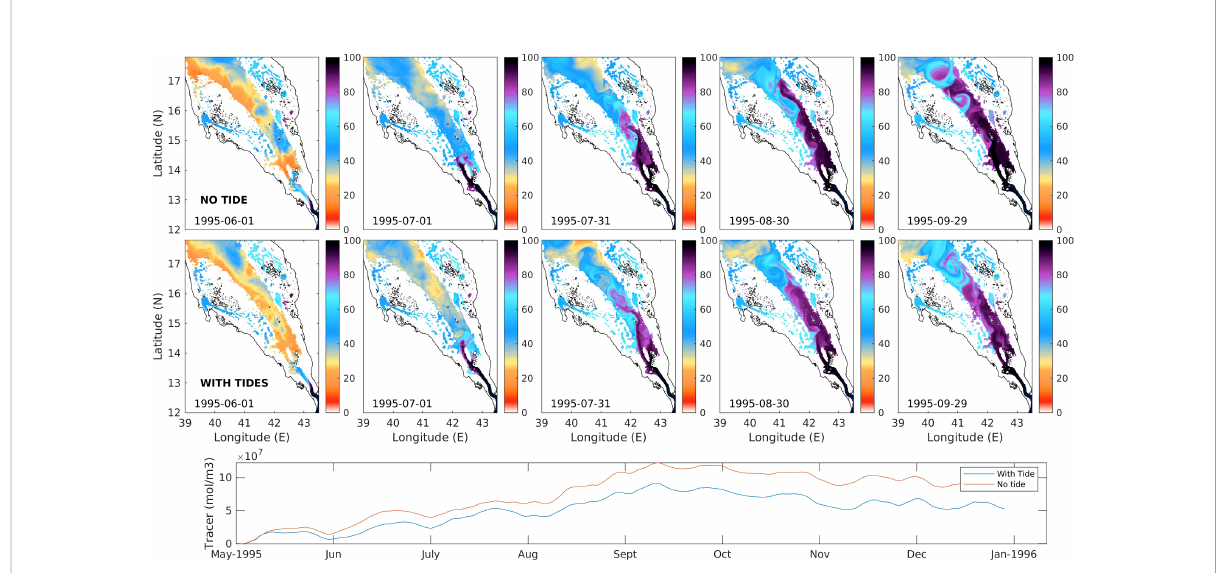
FIGURE 6 Five snapshots of the horizontal view of tracers in the southern Red Sea at the depth of 100 m in run without tides (top panels) and with tides (mid panels). Bottom panel shows the time series of the accumulated spatial mean of tracer numbers in the southern Red Sea, with red curve indicating run without tides and blue for run with tides.